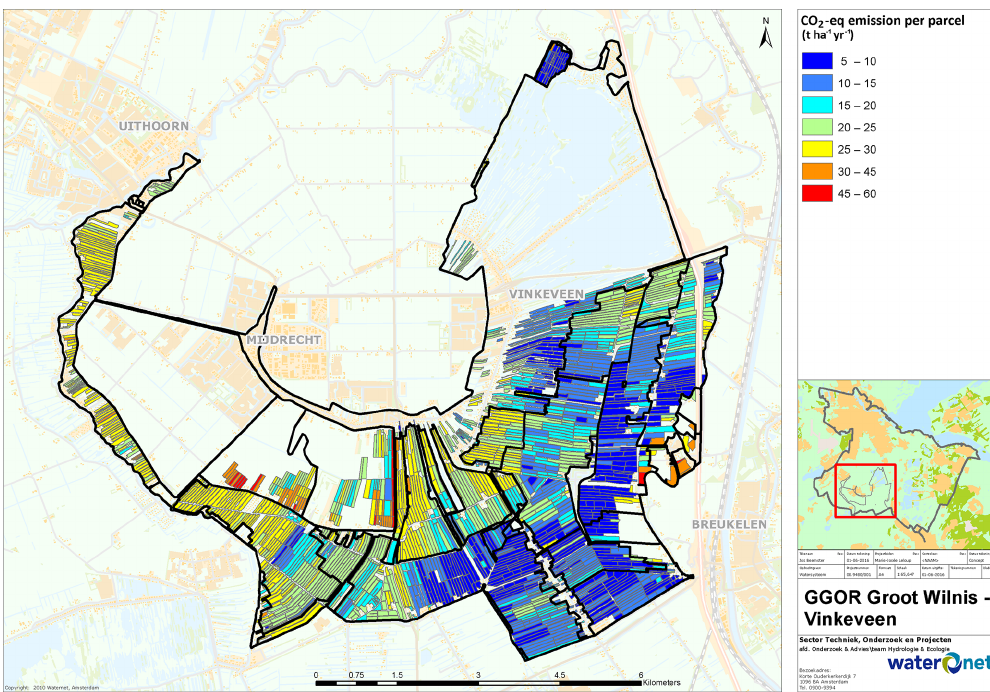
Figure 5. Calculated current CO 2 -eq emission per parcel in Groot-Wilnis Vinkeveen and Wilnis-Veldzijde based on mean ground water level (Jurasinski et al., 2016) with a correction for clay cover (source of topographic underlayer: © Kadaster, 2016).